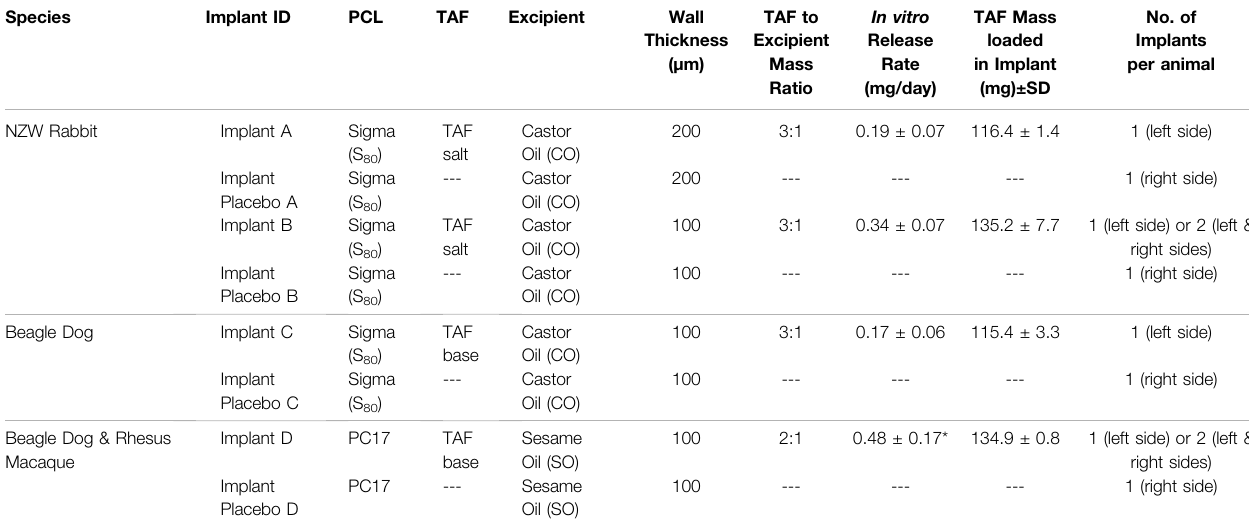
*Release rate of Implant D shown for in vitro studies that parallel the dog